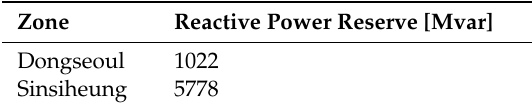
Table 3. Comparison of generator reactive power reserves between pilot points in the metropolitan area of the Korean power system.